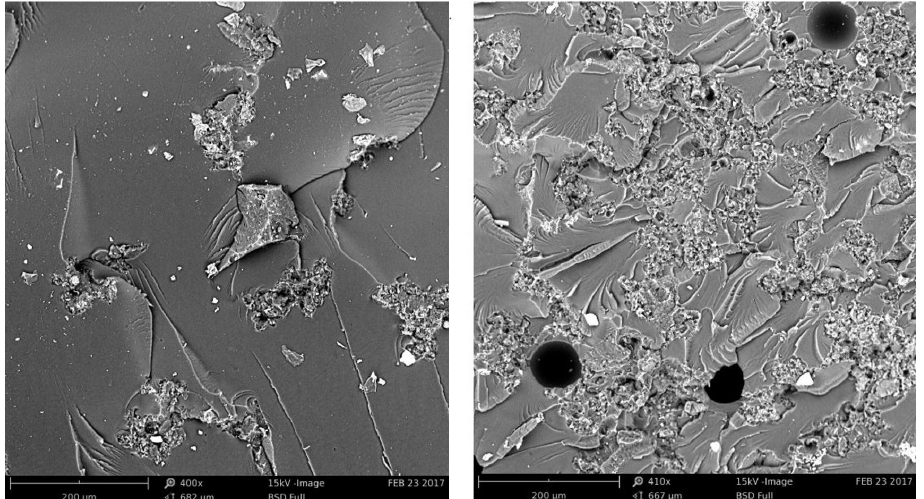
Figure 8. SEM Comparison between W.R.5% (left) and W.R.20%